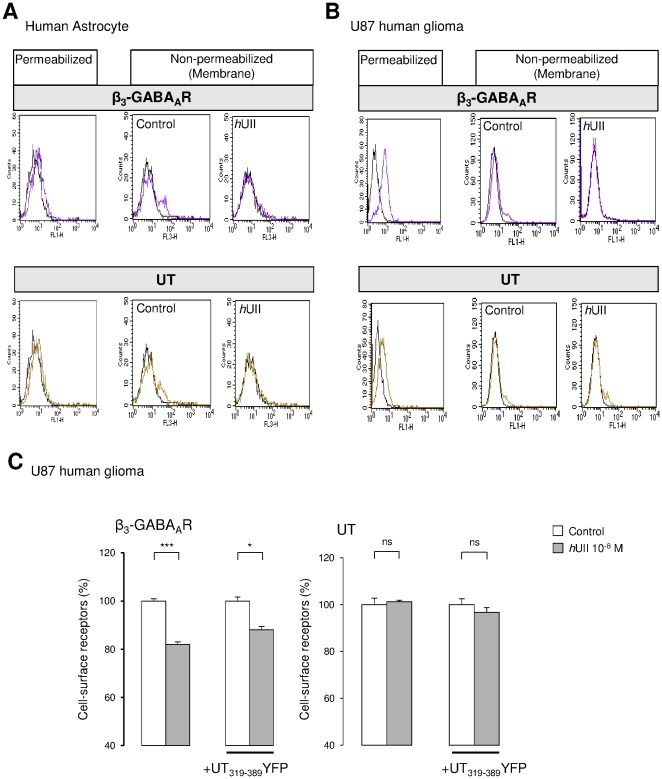
UII-evoked GABAAR internalization in native human astrocytes and glioma.(A, B) FIow cytometric analysis of the β3 GABAAR subunit and UT expression in native human astrocytes (A) and human U87 glioma cell line (B). Cells were stained with the anti-human β3 subunit or anti-human UT in permeabilized or non permeabilized conditions (membrane receptor). The black lines depict results from control staining with only secondary antibodies. The β3 GABAAR subunit or UT cell surface expression was evaluated in the absence or presence of hUII (10−8 M, 30 min) by flow cytometry. Data obtained in A and B illustrate two representative experiments showing β3 (magenta line) and UT (yellow line) mean fluorescence in the cytosol and at the plasma membrane of a minority of non permeabilized human astrocytes (A) or U87 (B) in culture. The exposure to hUII induced internalization of β3 in both cell types and of UT only in U87 glioma. (C) U87 glioma cell line expressing UT and GABAAR composed of β3 subunit, and transfected with the cDNA encoding UT319–389YFP, and immunodetected with anti-β3 (left) or anti-UT (right) antibodies. Percentage of cell surface β3 subunit (left) or UT (right) are represented as the proportion of receptor at the plasma membrane (non permeabilized cells) to the total expressed receptor (permeabilized cells). One hundred percent correspond to values in the absence of 30 min treatment with hUII (10−8 M, 37°C). Each bar corresponds to mean ± SEM percent obtained from at least 3 independent experiments, in triplicates. ns, non significant; *, P<0.05; ***, P<0.001.